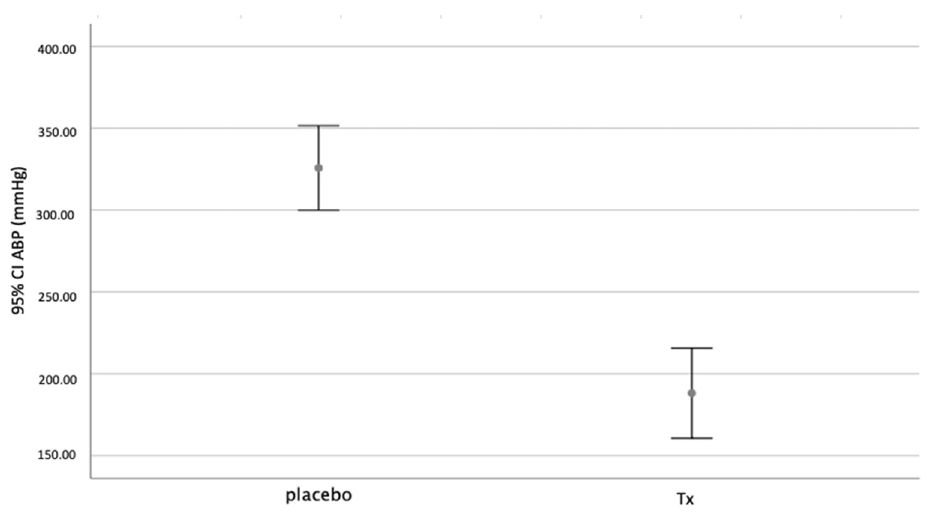
Figure 7. Mean traction pressure. p =